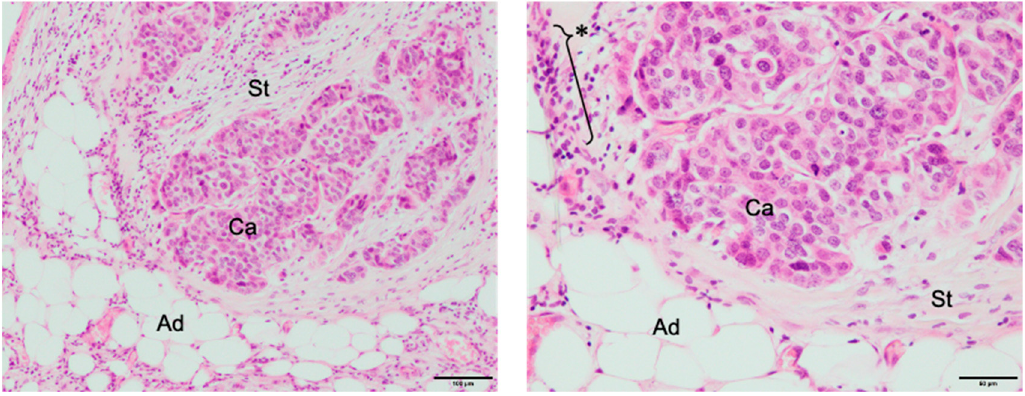
Figure 2. Breast cancer microenvironment. Ad, adipocytes; Ca, carcinoma cells; St, stroma area; *, aggregation of inflammatory cells. Left: low magnification (Scale bar, 100 μ m); Right: high magnification of Left (Scale bar, 50 μ m).